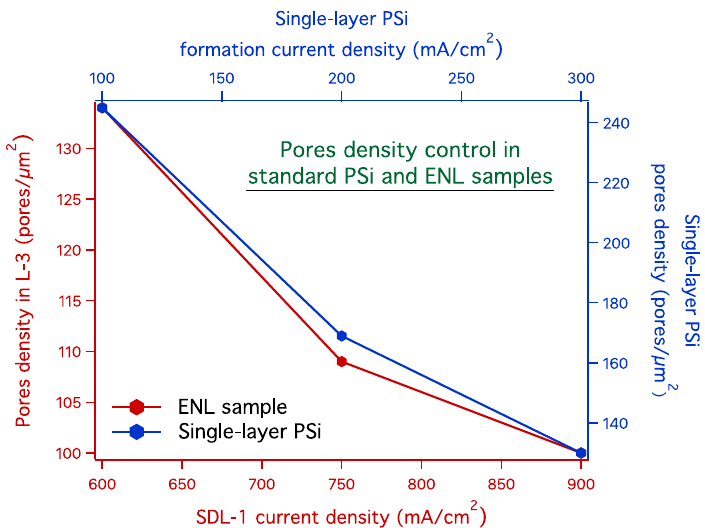
Figure 5. Evolution of the pore density in standard PSi samples and in samples after ENL. The graph reports the data for the pore density evolution as a function of the current density for standard PSi samples (blue curve and axes). The comparison is made with samples with ENL (red curve and axes). In the ENL double layer, the pore density was varied only in SDL-1, while the electrochemical parameters for SDL-2 were identical in all cases. The pore density for ENL samples is measured in the L-3 layer. All pore densities are measured on cross-section SEM images, as explained in the text.